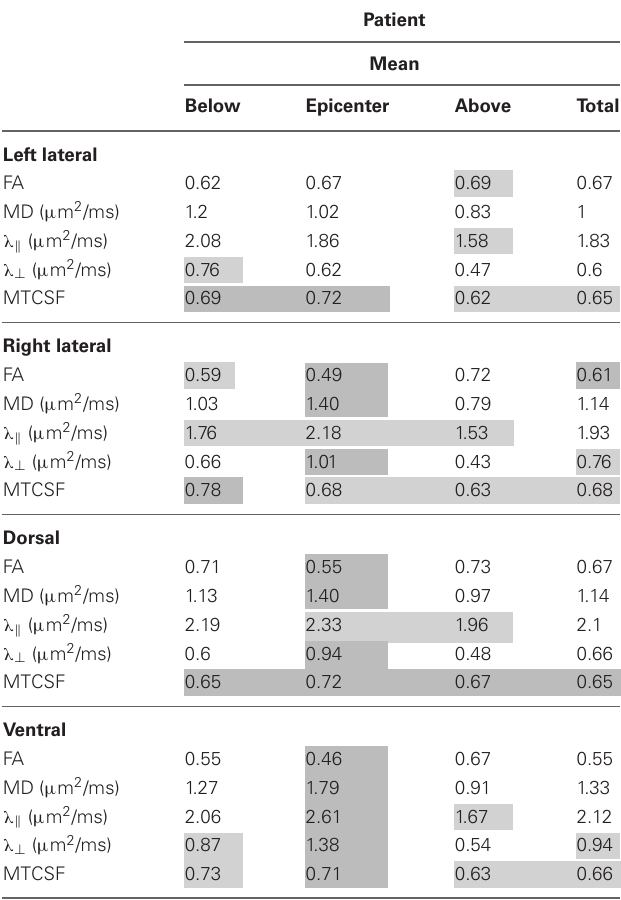
Table 2 | Injury region specific data comparison of the